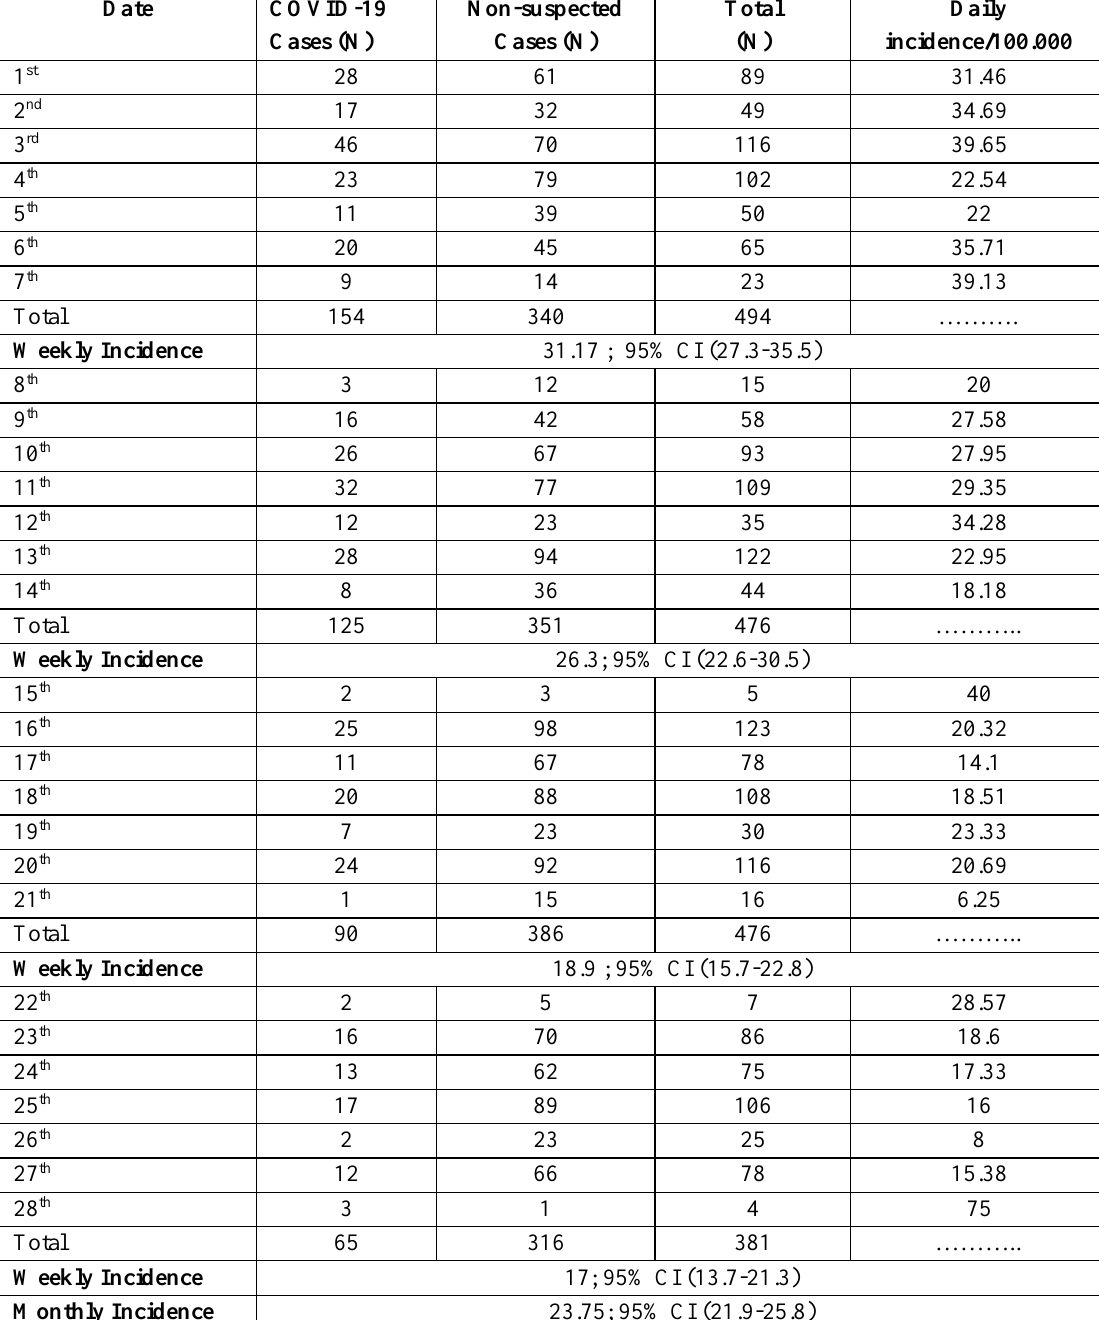
Table 1. Incidence of moderate and severe COVID-19 at ZUH during January